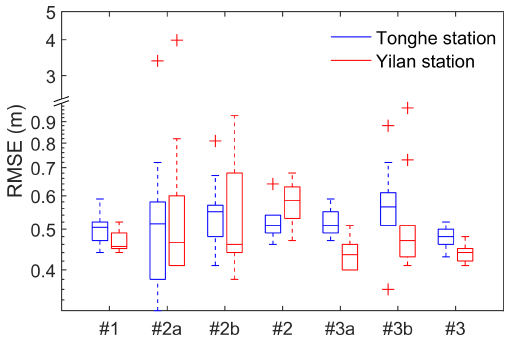
Figure 5. Boxplots of evaluations of simulated water level against in situ gauging records at two gauging stations. Calibration scenar- ios indicated on the x axis are referred to Table 1. Note that the y axis is in log scale. Note that the statistics for each scenario are computed from the 10 calibration runs with different starting